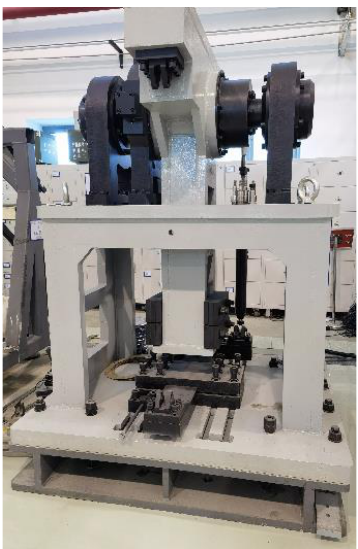
Figure 10. Photos of load simulator.